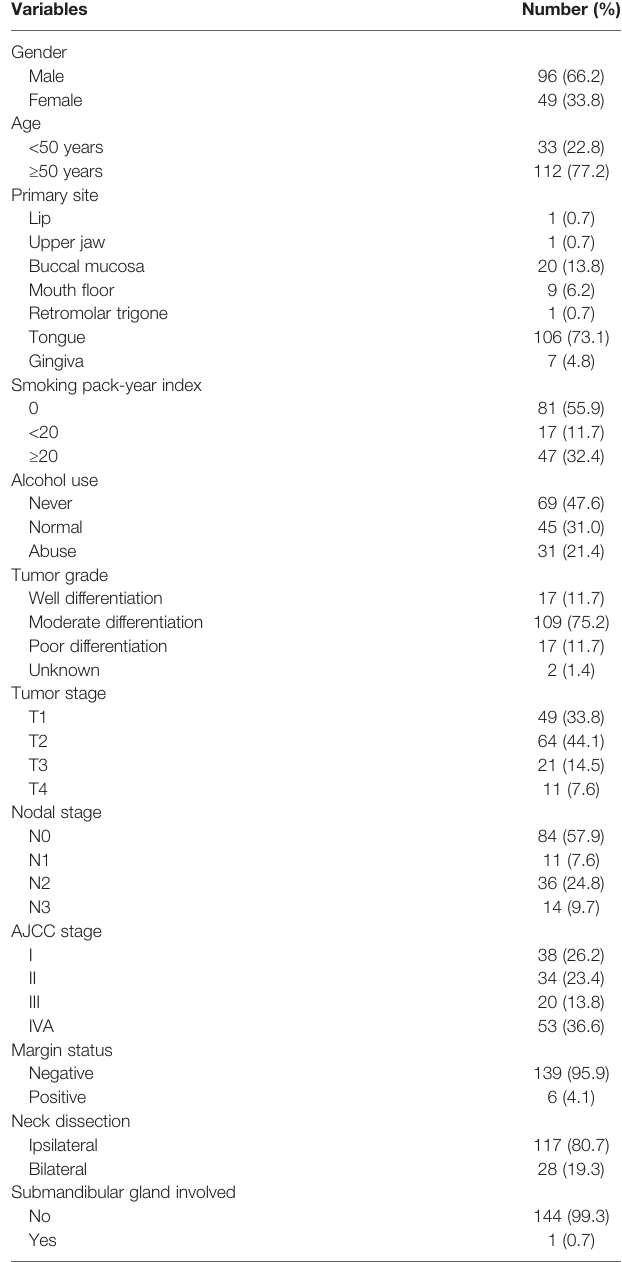
TABLE 1 | Patient